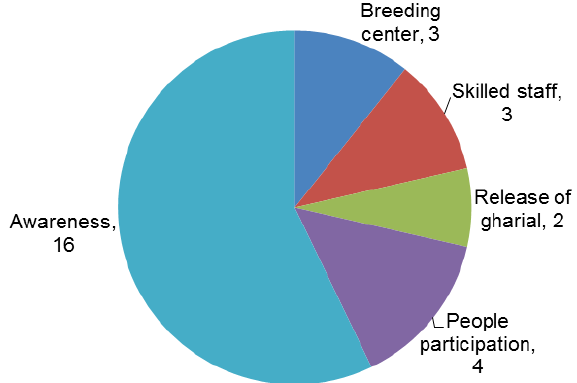
Figure 2. Conservation of crocodile according community perceptions